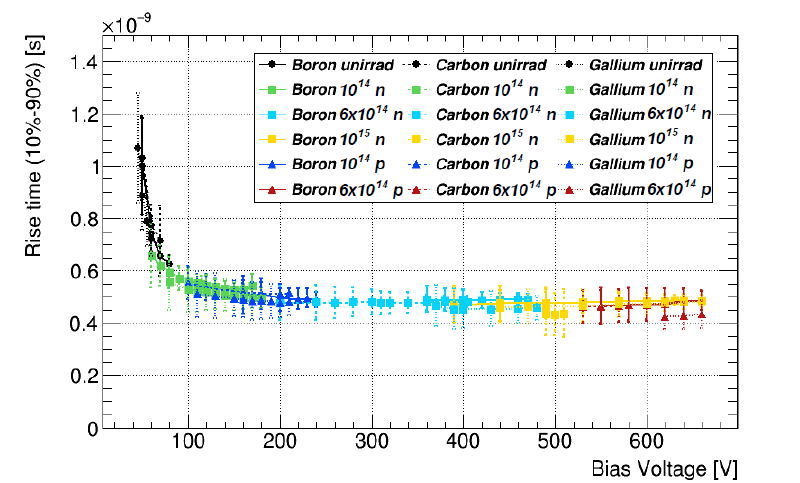
Figure A5. Rise time as a function of the bias voltage for CNM LGADs irradiated up to a fluence of 10 15 n eq /cm 2 at − 30°C. The error bars are determined from a Gaussian